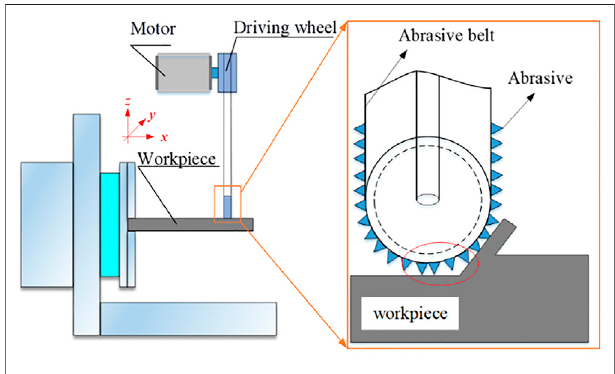
FIGURE 1 | Belt grinding system.